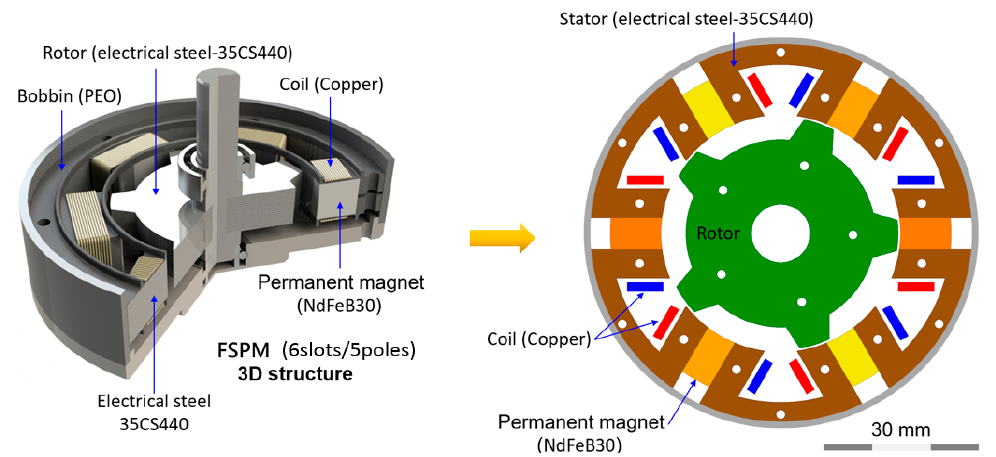
Table 1. The specification of the as ‐ designed 6/5 FSPM.